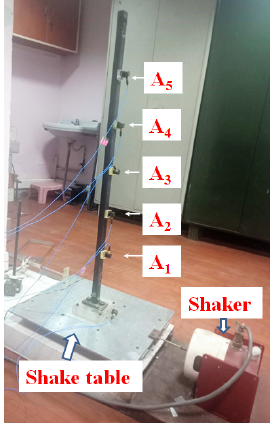
Figure 1: Experimental test set-up of CFRP composite square hollow tube